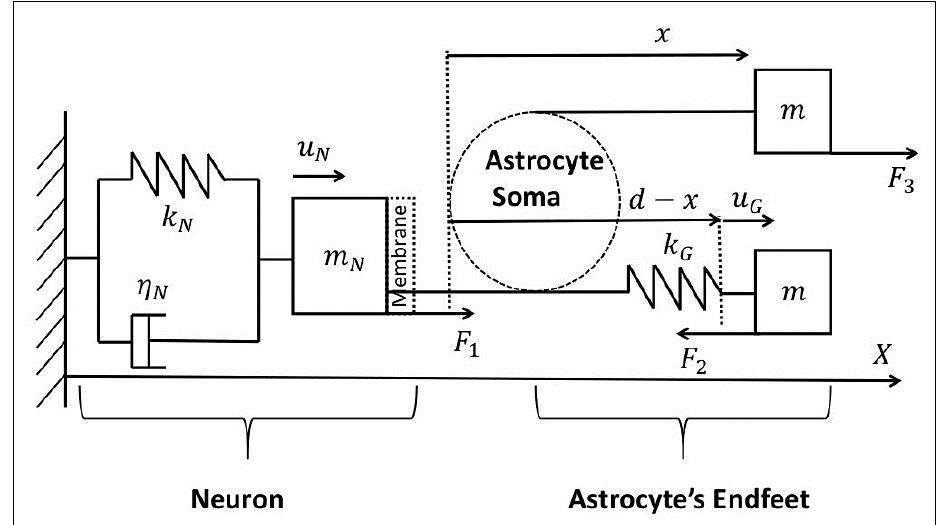
Figure 4. Schematic of a brain-on-a-chip made of a coupled neuron (modeled as a linear viscoelastic Kelvin-Voigt element connected to a mass) and astrocyte’s endfeet. The endfeet are modeled as a spring-mass mechanical system and another mass connected to the astrocyte’s soma by a frictionless massless wire. In this mechanical system, the astrocyte’s soma acts as a massless frictionless